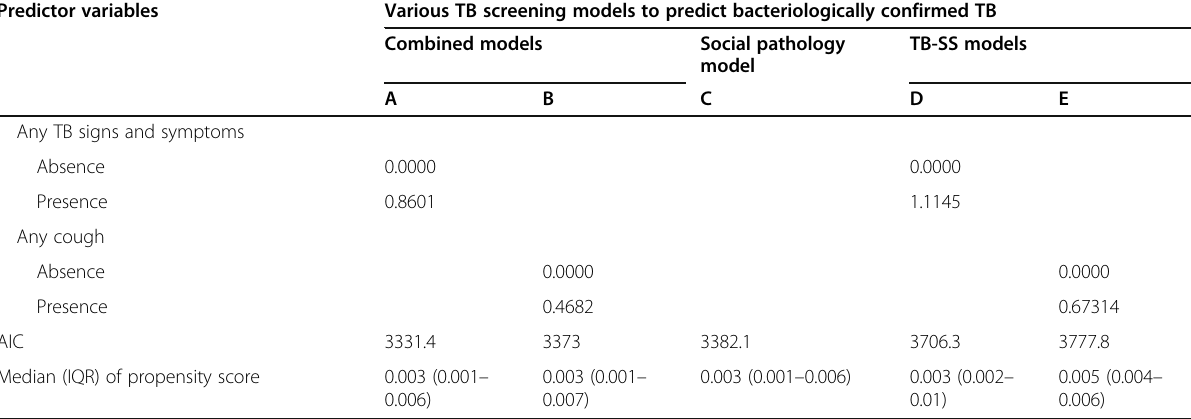
Table 4 Various TB screening models to predict bacteriologically confirmed TB in logistic regression analysis (Continued) Predictor